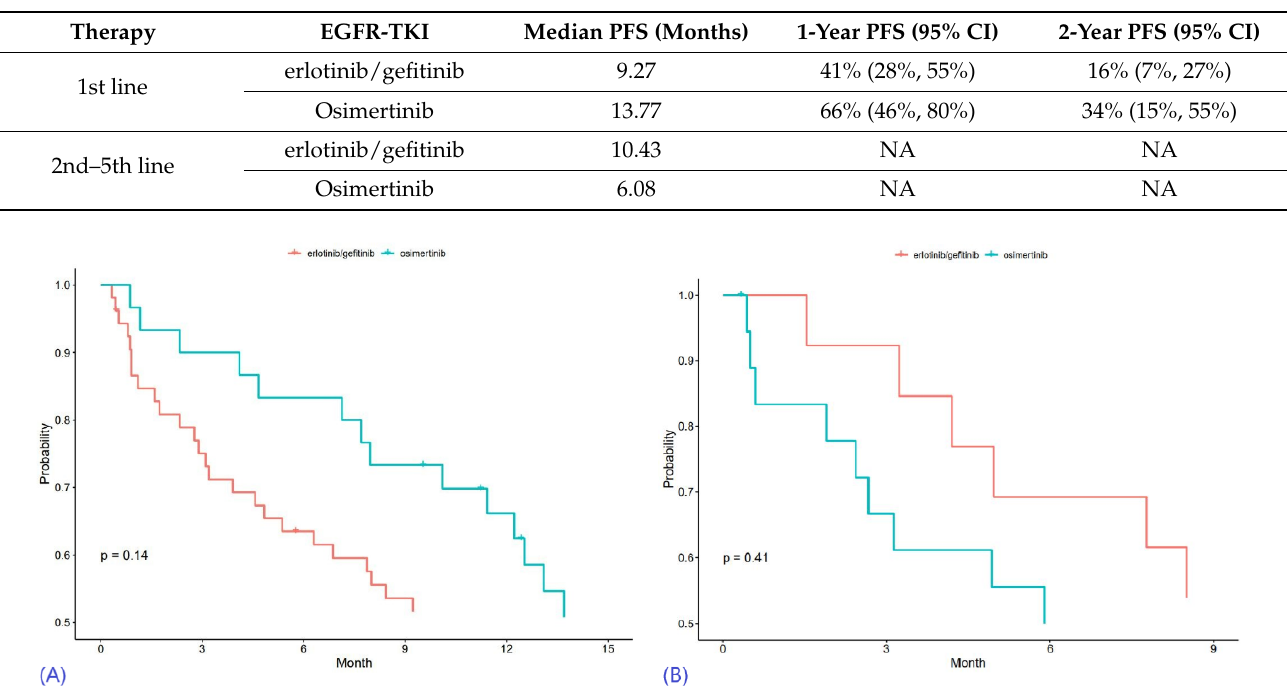
Figure 3. Kaplan-Meier curves for progression-free survival, with results of first-line therapy in ( A ) and outcomes of later-line therapy in ( B ). Table 8. Unadjusted Progression-free survival (PFS) of patients with NSCLC brain metastases treated with first-generation and third-generation EGFR Tyrosine Kinase Inhibitors (EGFR-TKIs). NA: Not Available